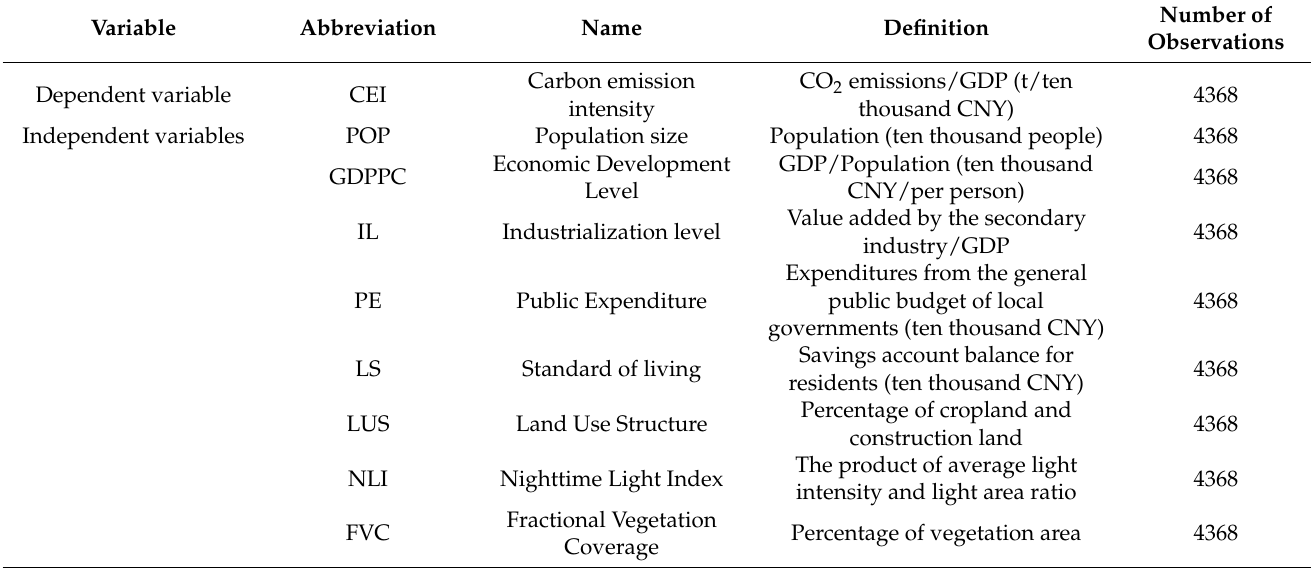
Table 1. Variable